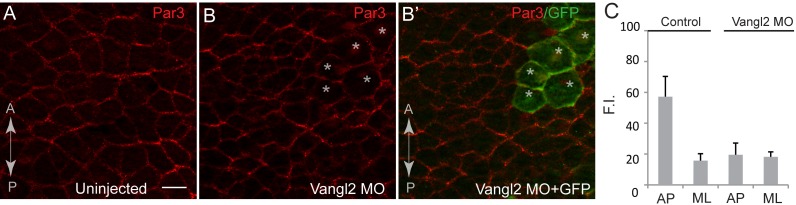
Planar polarity of Par3 is lost in Vangl2-depleted cells in the neural plate.(A, B) En face view of immunostained neural plate explants from fixed Xenopus embryos at stages 15/16. The anteroposterior (AP) axis is shown. (A) Par3 is enriched at the anteroposterior cell borders in untreated cells. (B, B’) Polarization of Par3 at the anteroposterior cell borders is no longer detected in Vangl2 MO injected cells (asterisks). (C) Results are shown as means ± s. d., with each group containing ten embryos. At least 15 cells from two embryos were analyzed per group. F.I., Fluorescence intensity. The experiment was repeated two times. Scale bar, 20 µm.